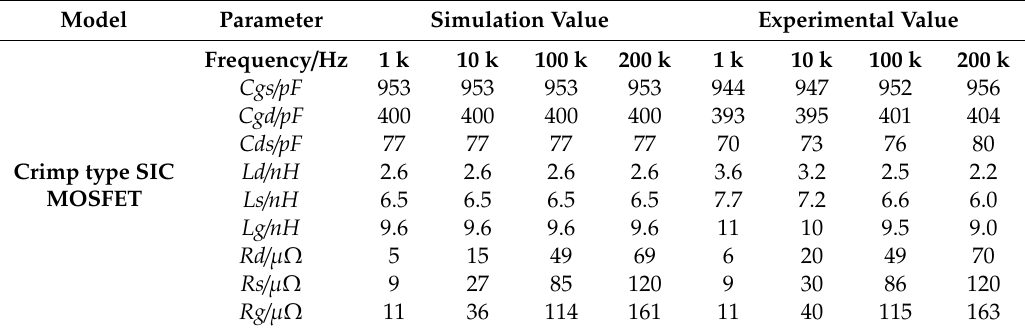
Table 1. Parasitic inductance, resistance, and capacitance values of the MOSFET poles to ground. Model Parameter